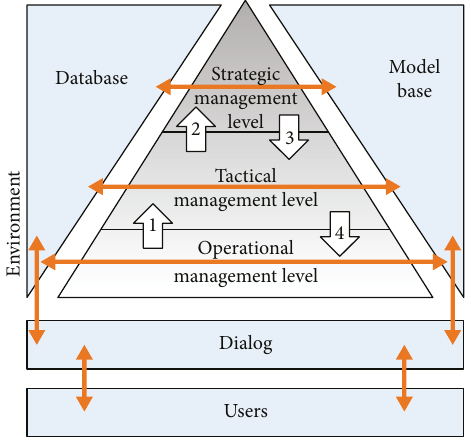
Figure 1: Structure of the decision support concept for urban road infrastructure